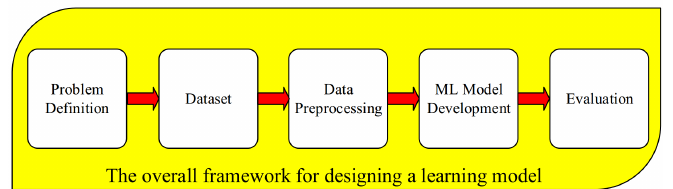
Figure 3. Different phases for designing a learning